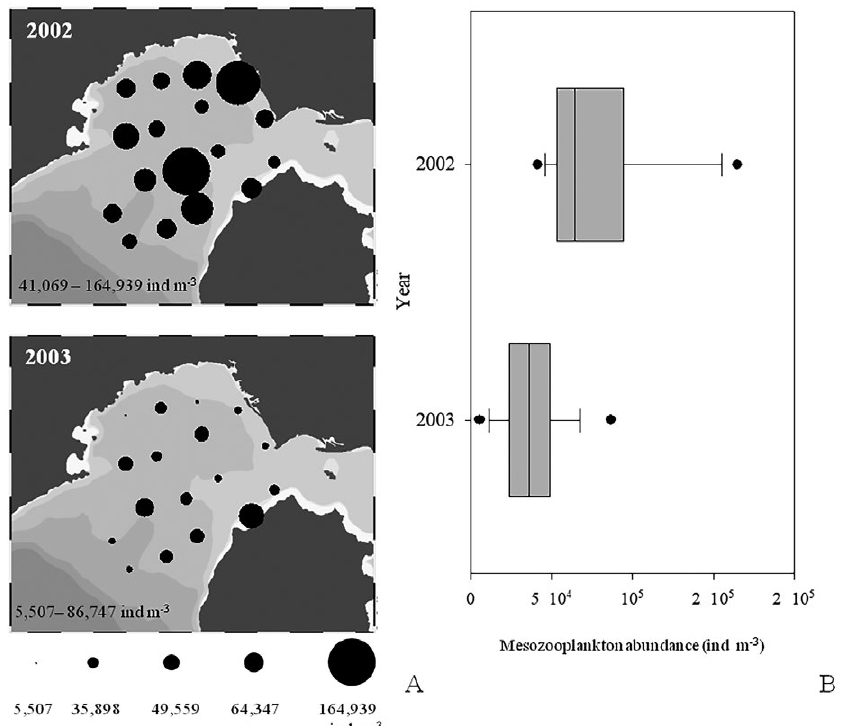
Fig. 2. – A, distribution of mesozooplankton abundance in the water column in Kavala Gulf, northern Aegean in July 2002 and 2003. Values for smaller and larger disc (range of abundance values) are indicated. B, box plots of mesozooplankton abundance in Kavala Gulf, northern Aegean in July 2002 and 2003 grouped by sampling year. Outliers are plotted as